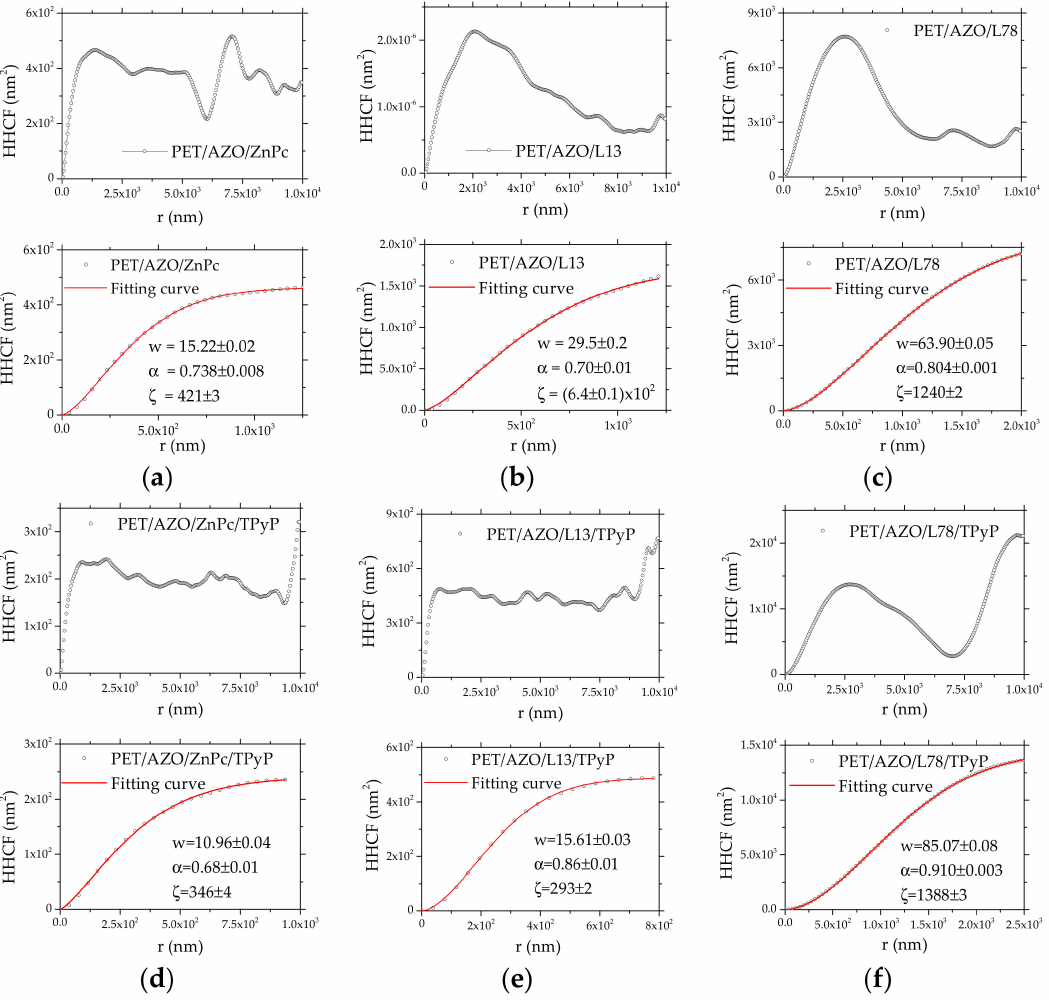
Figure 7. Height-height correlation function (HHCF) as a function of lateral distance, r, as obtained from the AFM surface profile scans, for large and small r: PET/AZO/ZnPc ( a ), PET/AZO/L13 ( b ), PET/AZO/L78 ( c ), PET/AZO/ZnPc/TPyP ( d ), PET/AZO/L13/TPyP ( e ), PET/AZO/L78/TPyP ( f